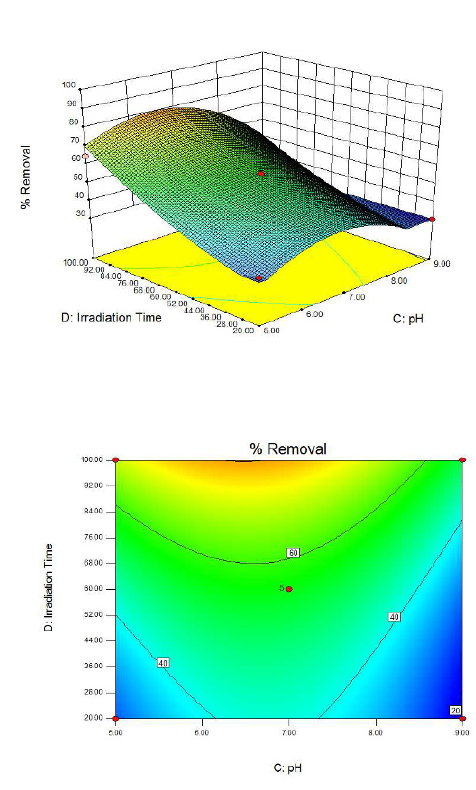
Figure 8. Response surface (Top) and contour plots (Bottom) show- ing the interaction between pH and Irradiation time for so- lar induced photocatalytic decolourization of dye effluent (Dye effluent concentration 60 mg L − 1 ; Catalyst dosage 125 mg L − 1